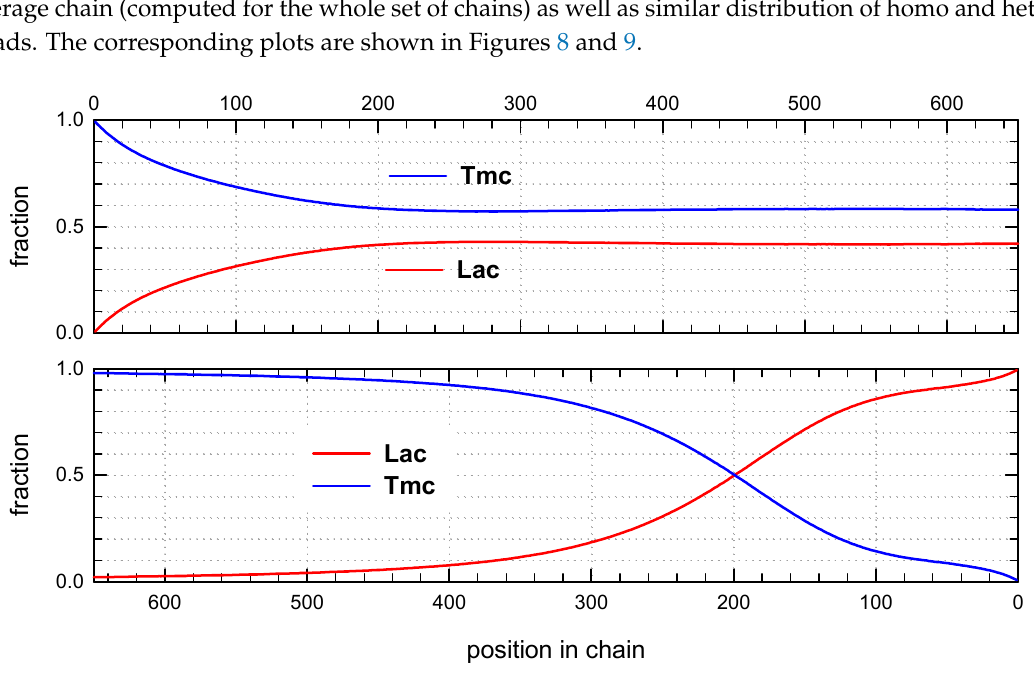
Figure 8. Distribution of copolymer units along an average chain expressed as mole fractions for system initiated with Tmc- R -Ini * unimer. The relative kinetic parameters as shown in Table 2 and caption to Figure 6. Unit positions numerated from chain beginning ( top box ) and from the chain-end ( bottom box ).